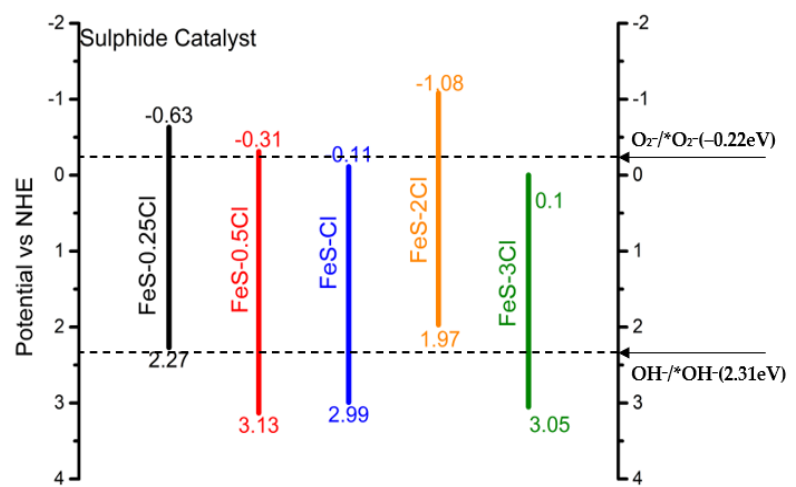
Figure 21. Proposed schematic diagram of the energy band configuration of sulphide catalyst het- erojunction.